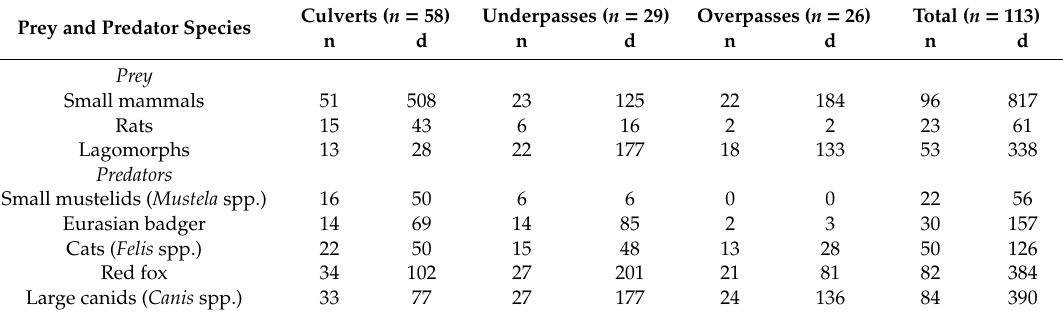
Table 1. Sample size of the data used to build co-occurrence models by species and passage type. n = the number of structures used by each species. d = the number of days on which each species was recorded. n = the total number of each structure type